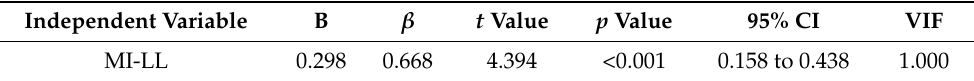
Table A4. Dependent variable: BBS. Independent variable: FMA-LL,